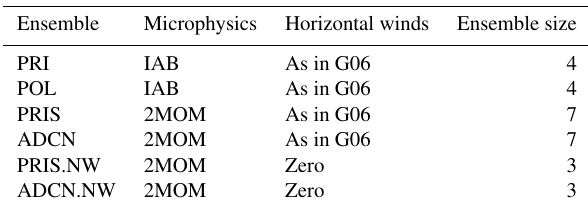
Table 1. Ensembles of the dynamic model simulations discussed in this paper. All simulations apply the same computational do- main, horizontal grid length, and vertical grid structure. G06 is Grabowski et al. (2006). IAB is the microphysics scheme discussed in Grabowski (1999) that features single-moment warm-rain and ice microphysics with prescribed cloud droplet concentrations and excludes water supersaturation by applying saturation adjustment. 2MOM is the double-moment microphysics described in Morrison and Grabowski (2007, 2008a,b) with mass and number mixing ra- tios for liquid condensate (i.e., four variables) and three ice vari- ables (one number mixing ratio and two mass mixing ratios). The 2MOM scheme predicts in-cloud supersaturation and allows water supersaturation. See text for more